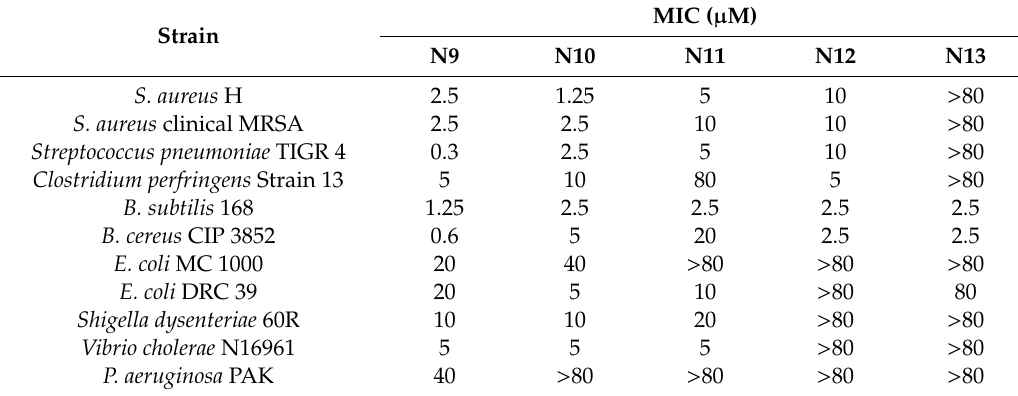
Table 3. MICs of Zantrins